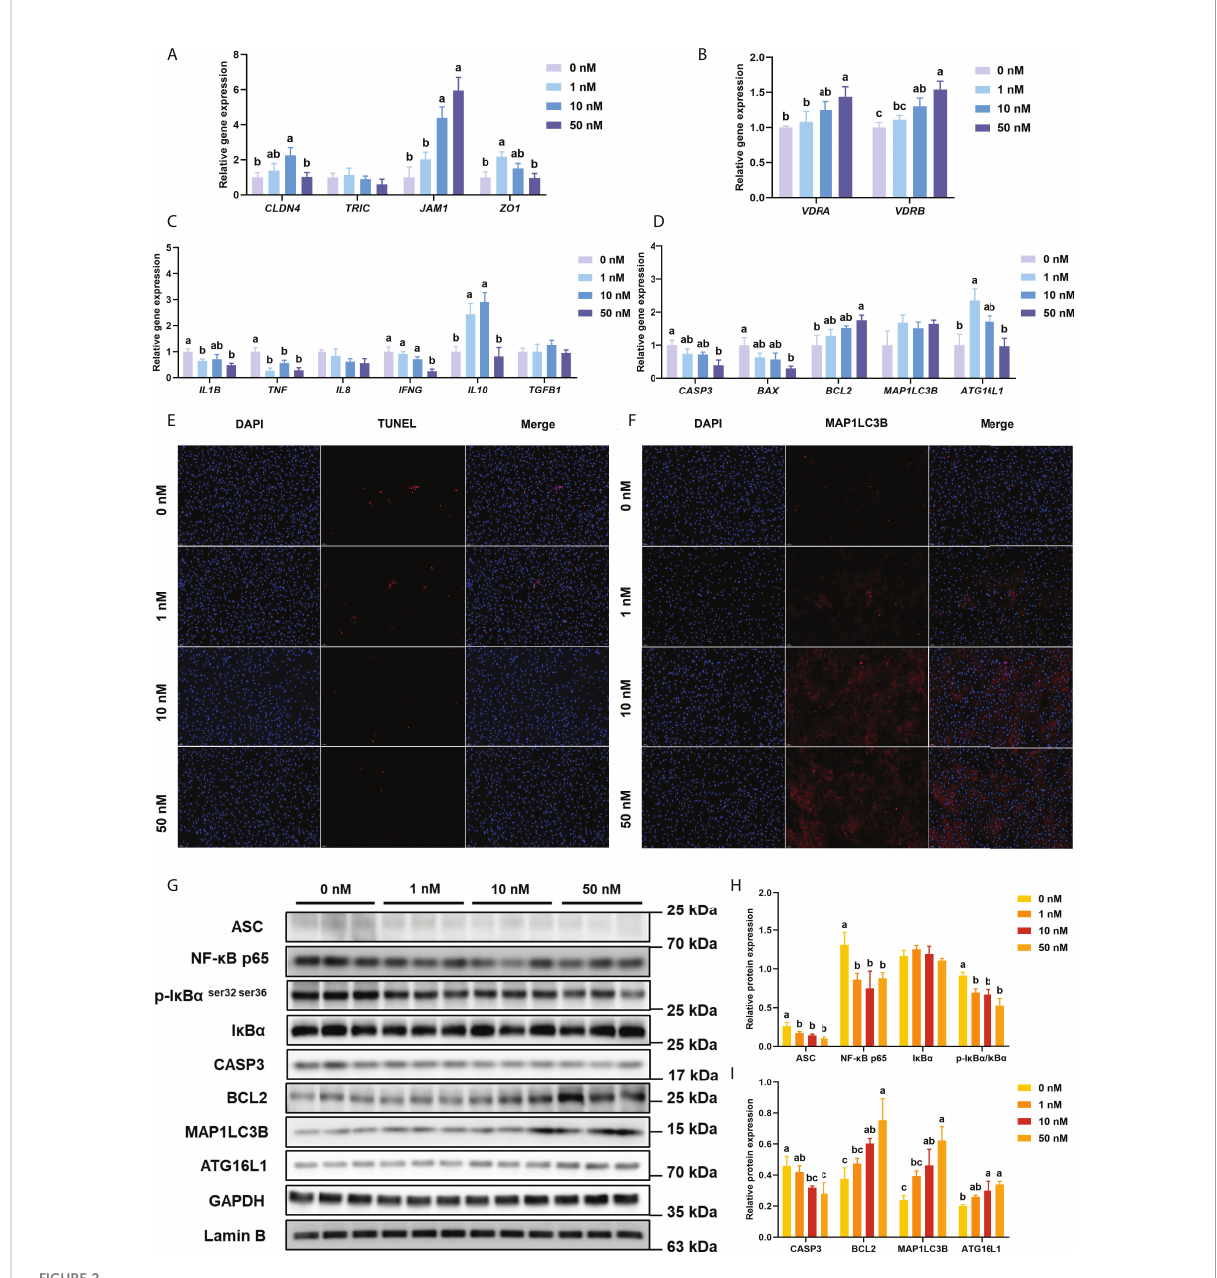
phosphorylated I k B, CASP3, BCL2, MAP1LC3B, and ATG16L1 were analyzed and quantitated by western blot. The blots of ASC, I k B a , p-I k B a ser32 ser36 , CASP3, BCL2, MAP1LC3B, and ATG16L1 were used for GAPDH loading control, while the blot of NF- k B p65 was used for Lamin B loading control. Error bars of columns denote SD (n = 3), and columns with different letters above them are signi fi cantly different ( P <